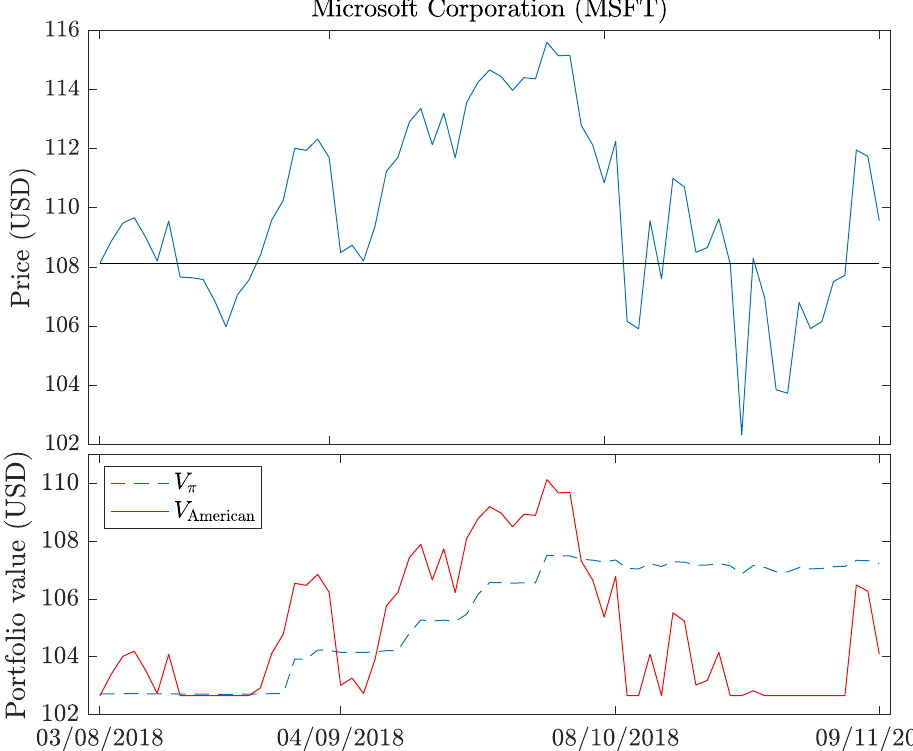
Figure 12. Microsoft Corporation stock closing prices ( top ) and payoffs of portfolios with parameters from Table 4 ( bottom ).